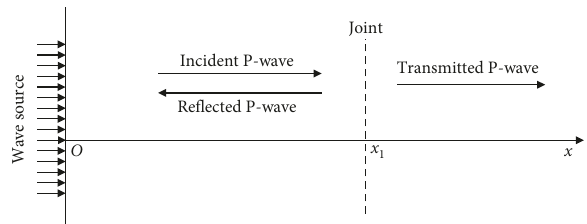
Figure 4: Mechanical calculated model of transmission of a P-wave across a single nonlinear joint in a rockmass.